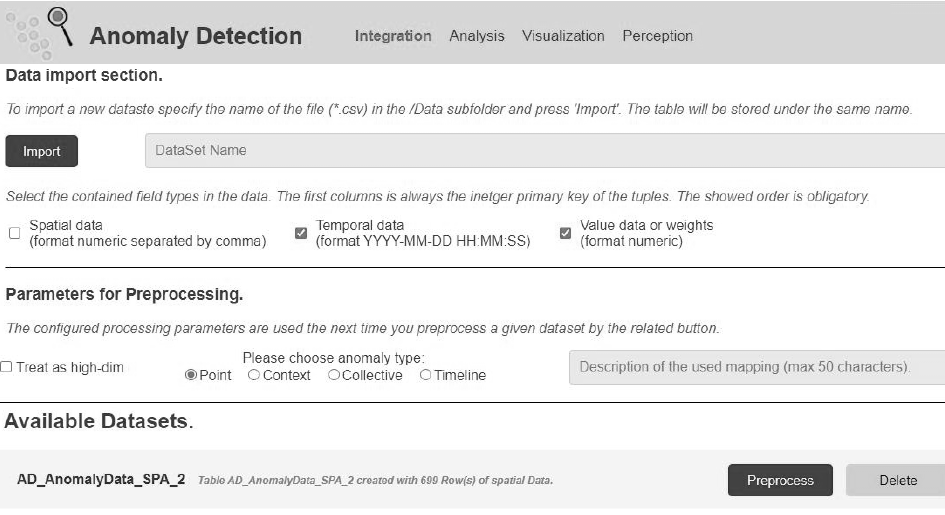
Figure 14. UI implementation for data integration, preprocessing, and